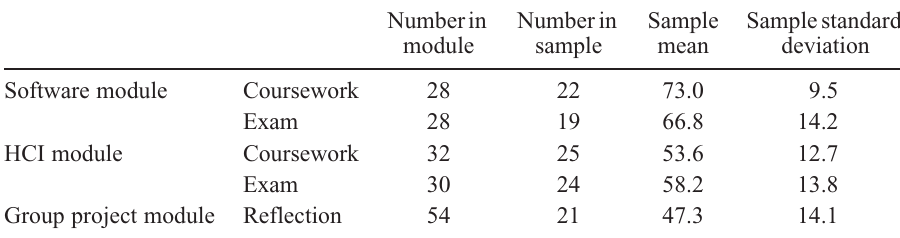
Table 1. Summary statistics of the coursework and exam marks used in the